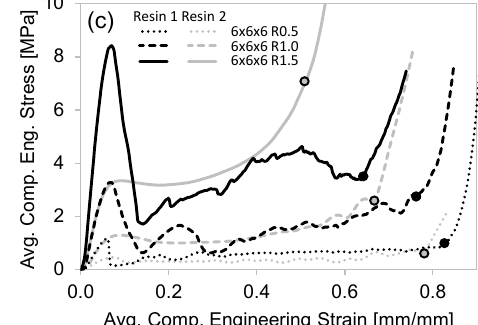
Figure 6. The average compression stress–strain curves for all the lattice samples: ( a ) The results for Resin 1; ( b ) the results for Resin 2; ( c ) a comparison of the Resin 1 and 2 results for the 6 × 6 × 6 lattice structures. The circular data point indicates the onset of densification.